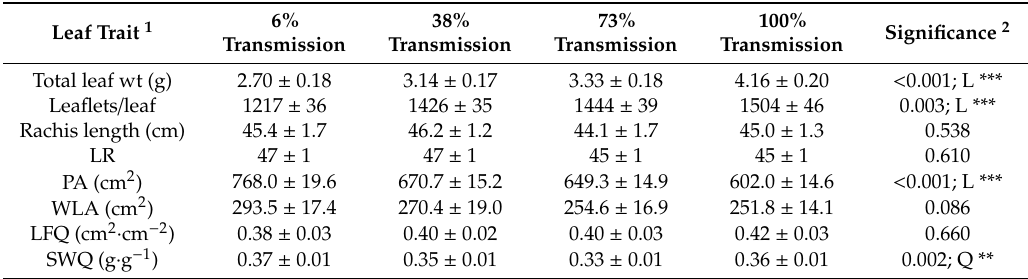
Table 2. Serianthes nelsonii leaf traits as influenced by percent sunlight transmission during leaf growth. Mean ± standard error.